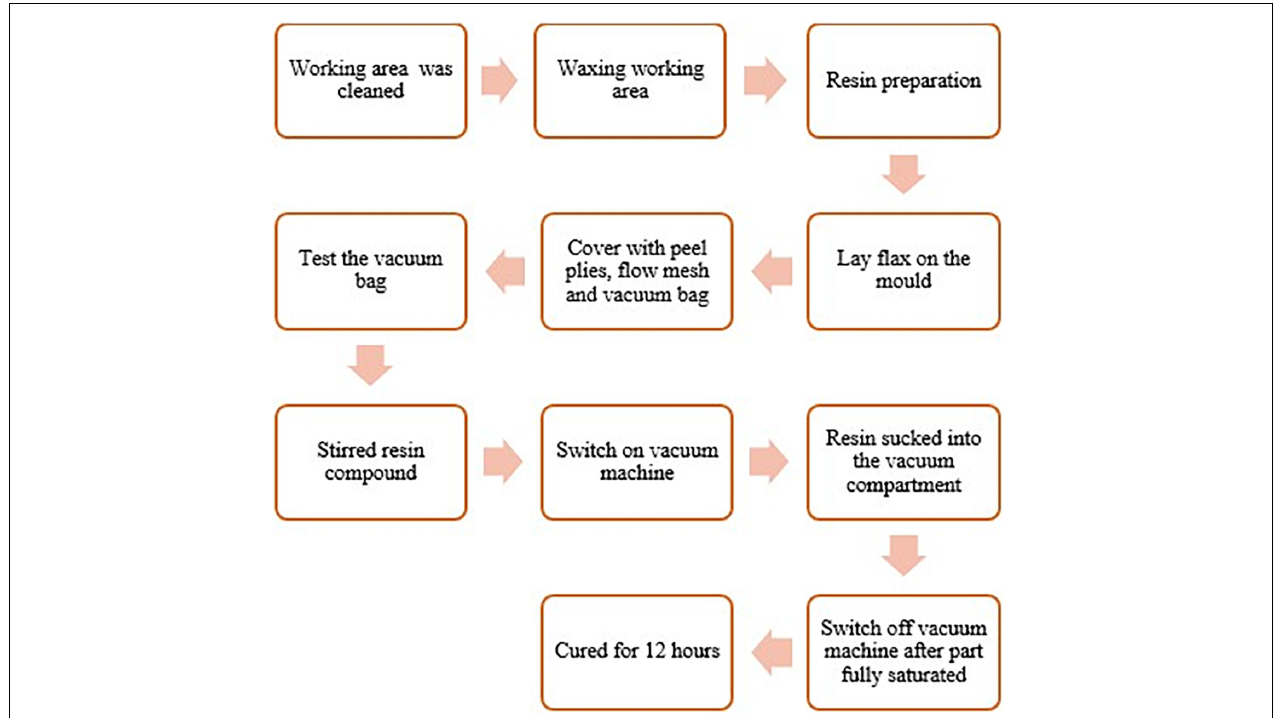
FIGURE 4 | Vacuum infusion process.